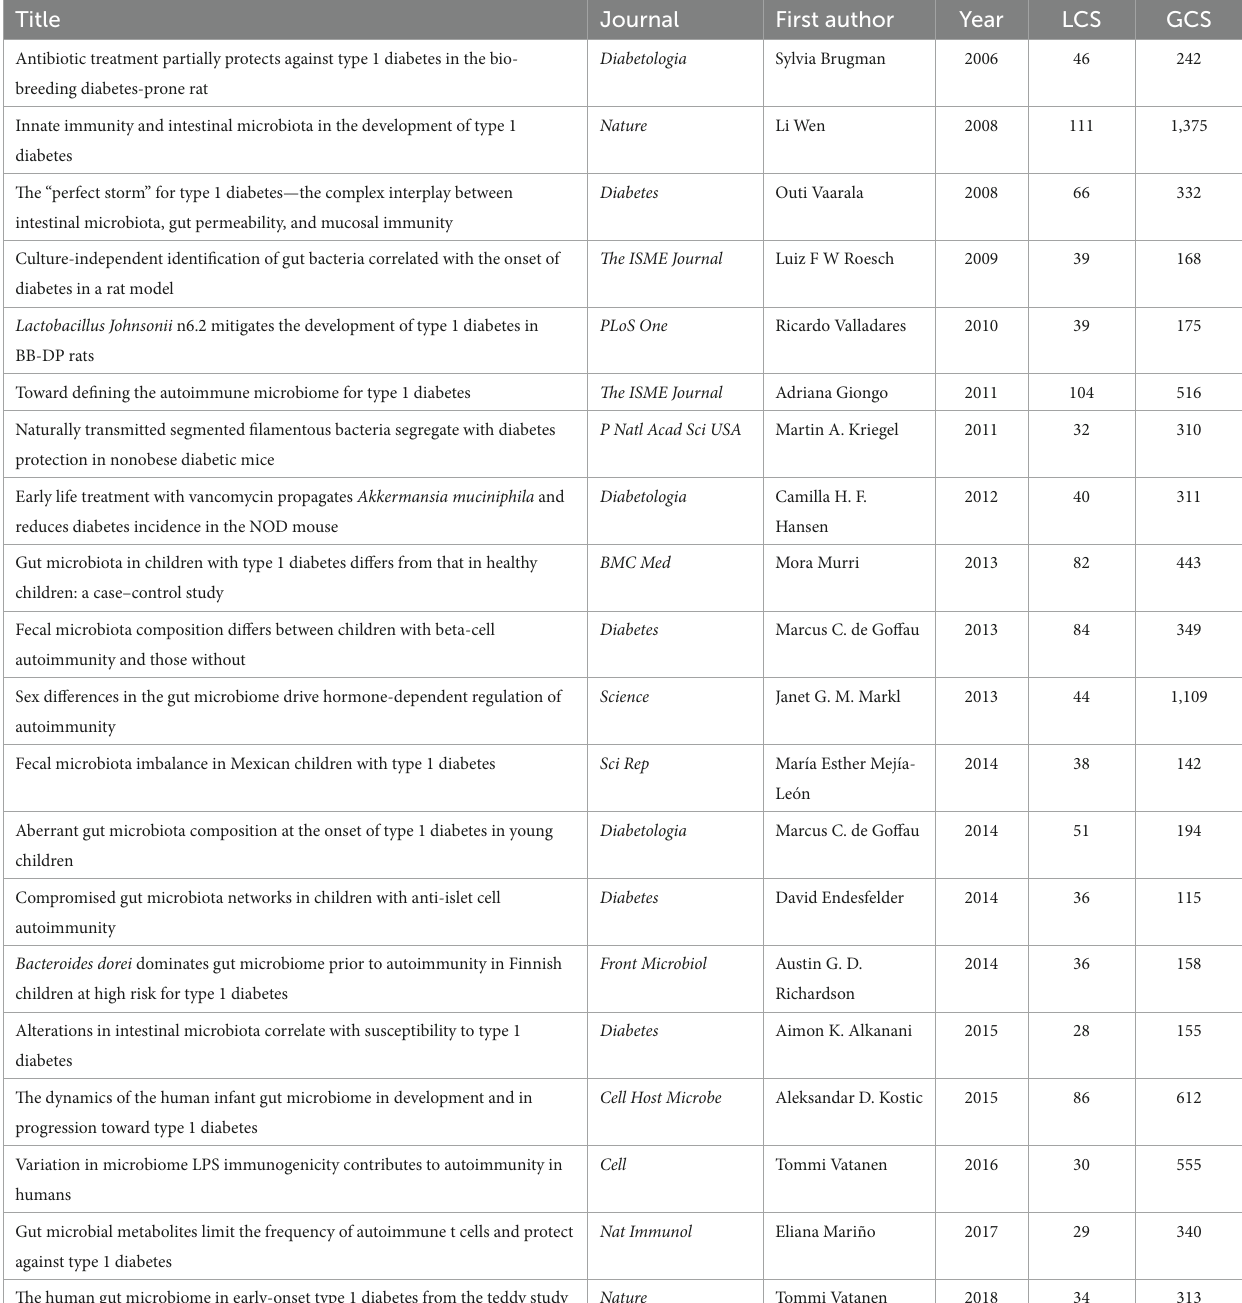
TABLE 5 Historical direct citation network of the